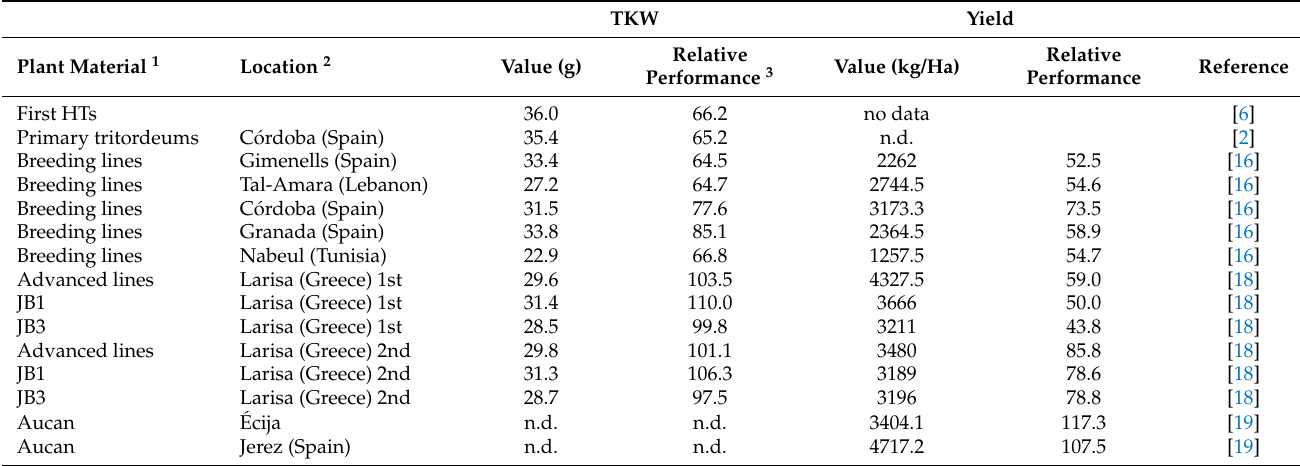
Table 1. Agronomic performance of tritordeum lines over